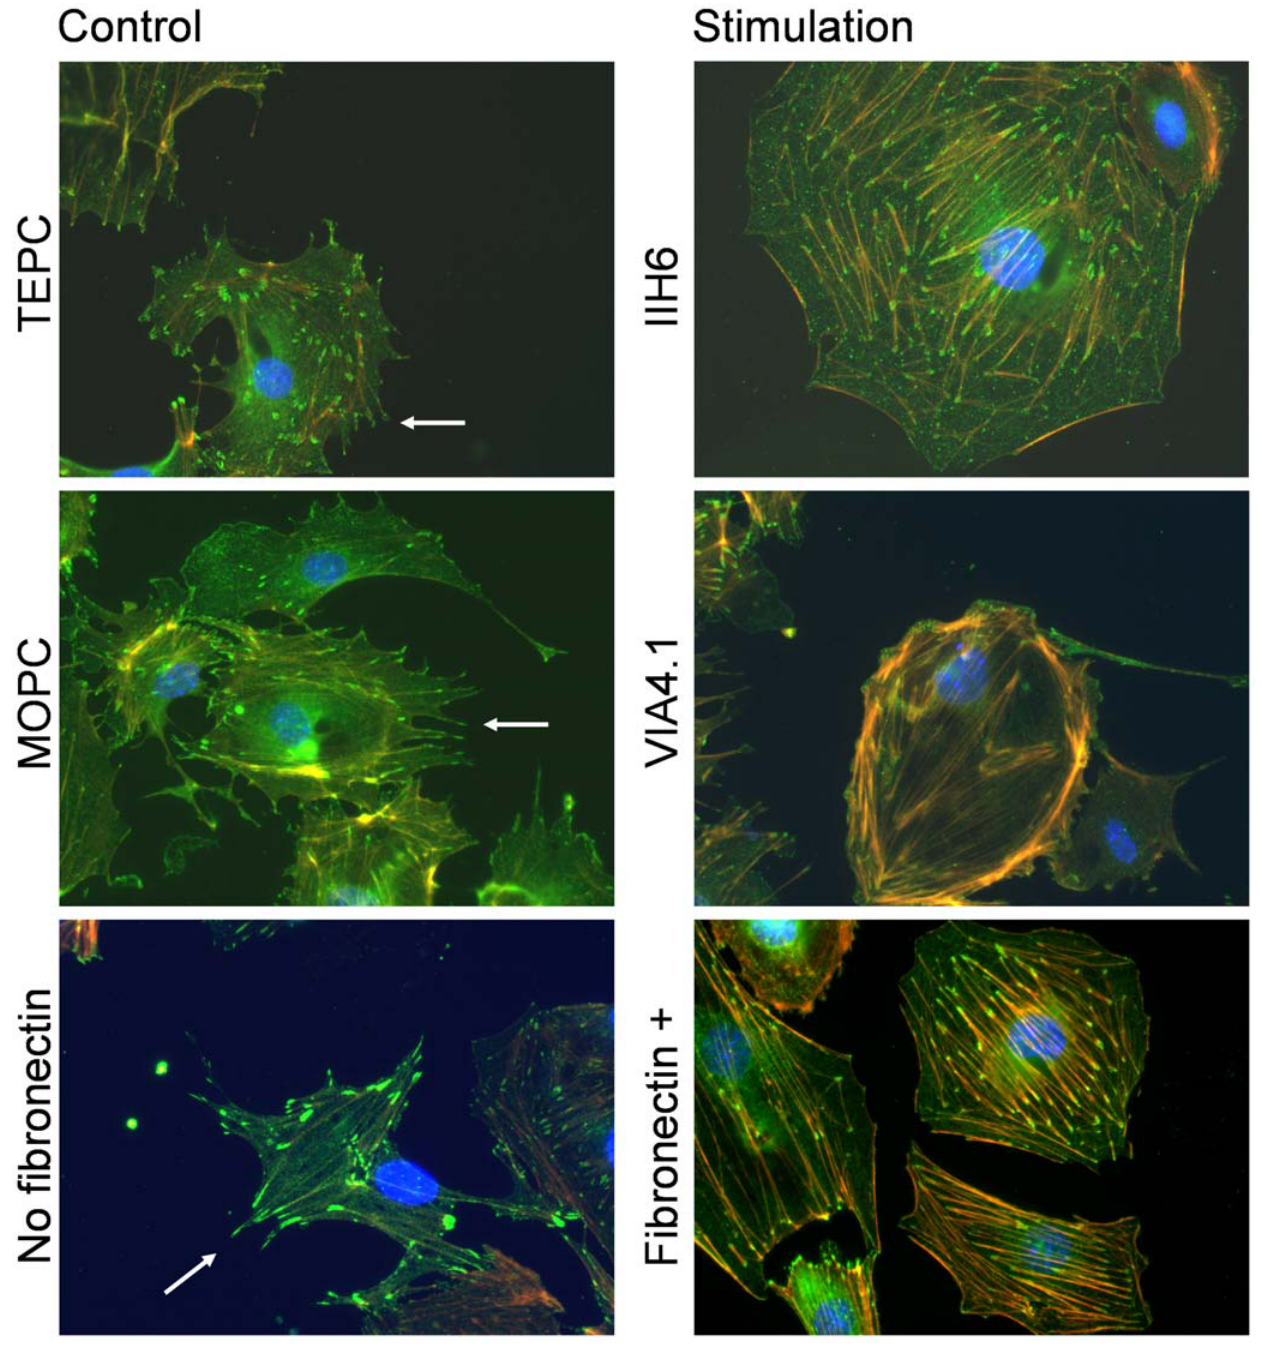
Figure 4. Ligation of a -dystroglycan results in a loss of pedicles in cultured mouse podocytes. Differentiated podocytes on collagen coatings were incubated with either monoclonal antibodies IIH6 or VIA 4.1, their respective isotype controls (TEPC or MOPC) or fibronectin. The podocyte pedicles (arrow) are probed with antibodies against Mena (green, which also localizes along stress fibers and in focal contacts at the tips of stress fibers [58,65]). The pedicles were lost after 6 hours of incubation with the antibodies. As these pedicles may be the in vitro manifestation of foot processes, their retraction may imply foot process effacement. Percentage of podocytes with smooth surfaces were counted, which yielded for IIH6 60% versus TEPC 30% ( x 2 =20.8, p , 0.001), for VIA4.1 51% versus MOPC 28% ( x 2 =9.01, p , 0.01) and fibronectin 38% versus control 30% ( x 2 =1.3, p=0.25). (Red=phalloidin (actin); blue=DAPI (DNA)). doi:10.1371/journal.pone.0005979.g004 dystroglycan represents an important mechanism for podocytes to negative charge [7]. In this study, we investigated whether anchor to the glomerular basement membrane. the dystroglycan complex is maintenance of the filtration slit by its